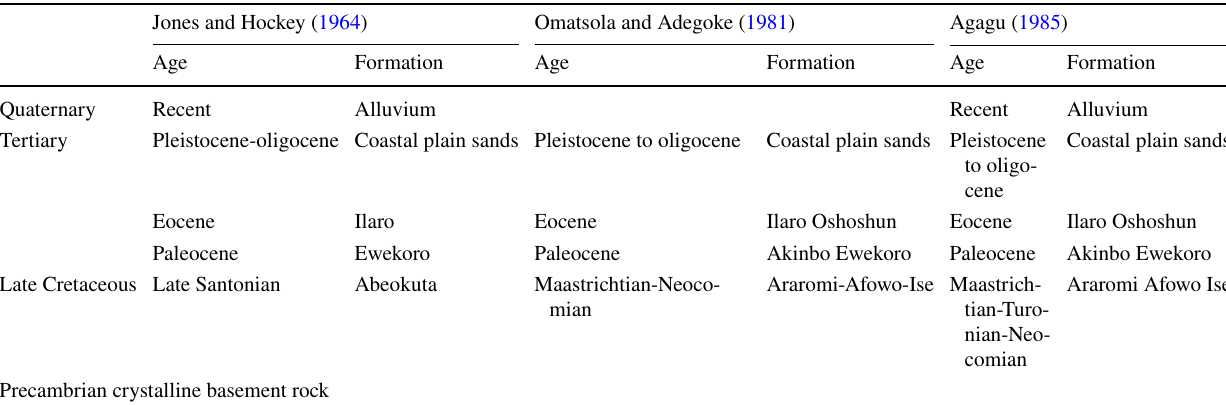
Fig. 2 Location map of the study area Table 1 Age and stratigraphic relationship of the formations of the Dahomey basin (Adapted and modified by various Authors) Jones and Hockey